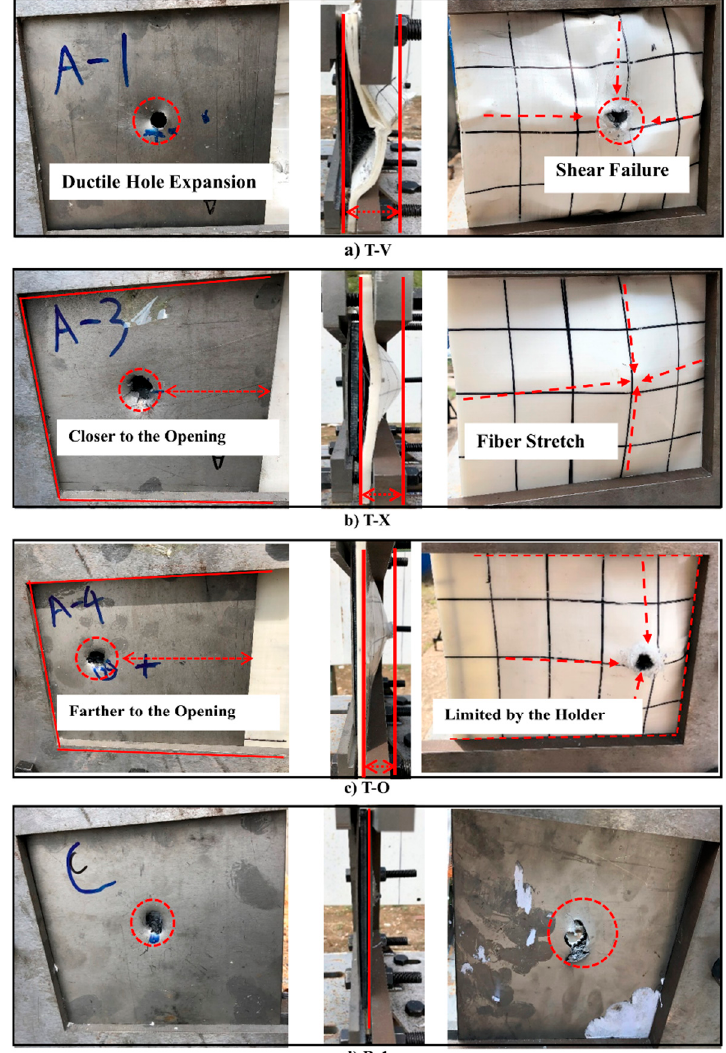
Figure 4. Pictures of the test and reference target after projectile impact. ( a ) Impact test of T-V. ( b ) Impact test of T-X. ( c ) Impact test of T-O. ( d ) Impact test of R-1.